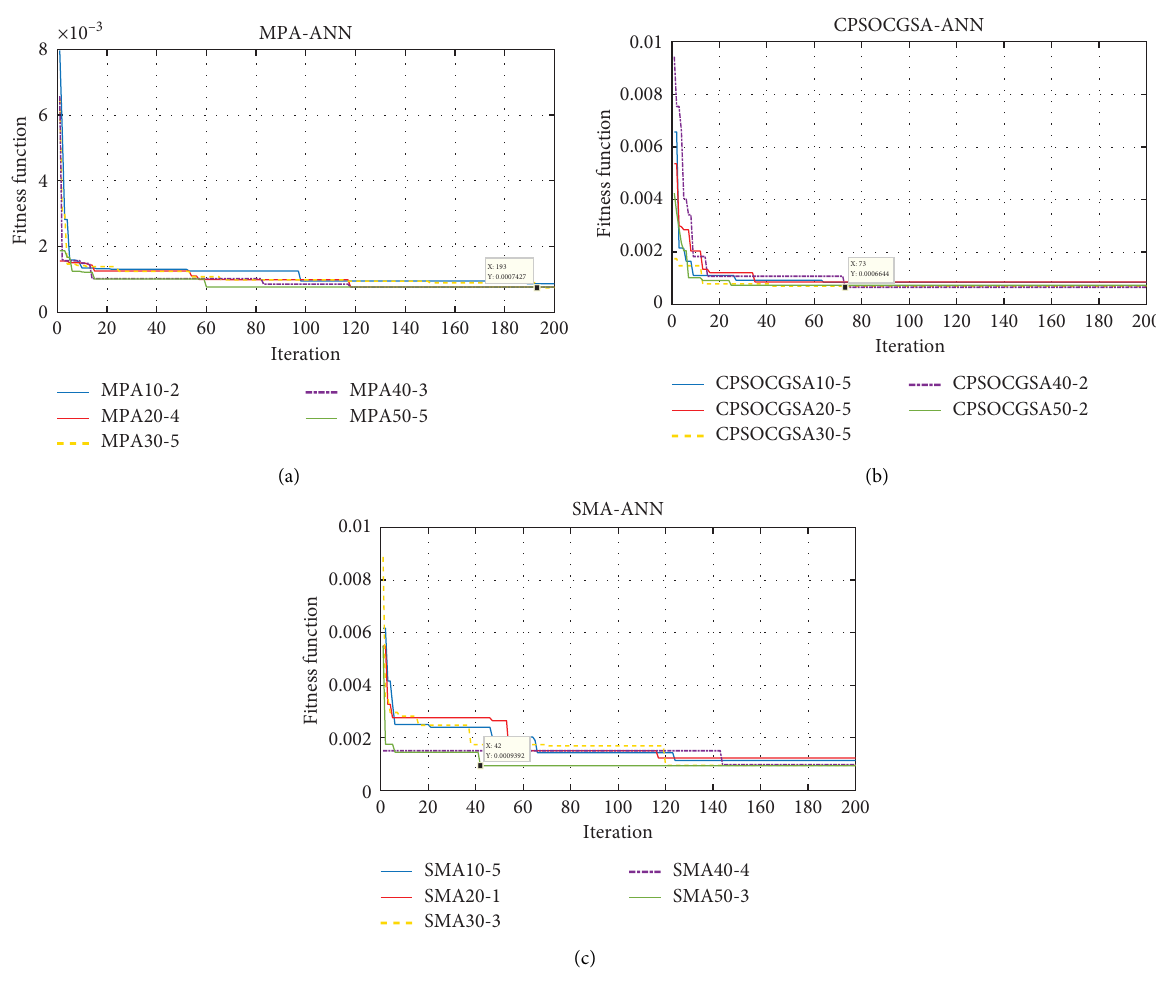
Figure 7: The best swarm for MPA, CPSOCGSA, and SMA algorithms. Table 3: ANN hyperparameters of all algorithms.